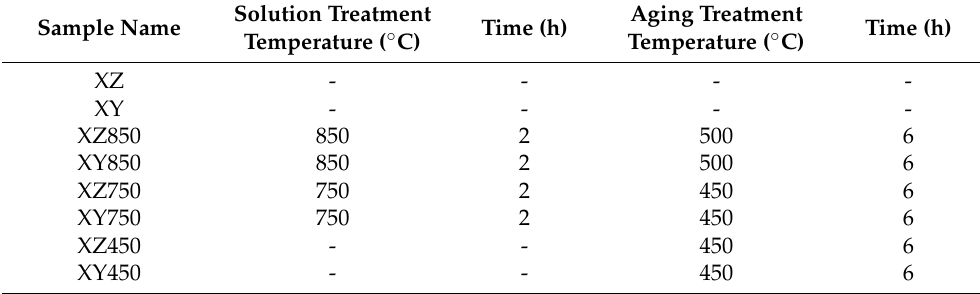
Figure 1. ( a ) Schematic diagram of sample geometries, scanning strategy, building direction, corrosion test planes, and ( b ) various heat treatment processes. Table 3. Sample notation according to the post-heat treatment condition.